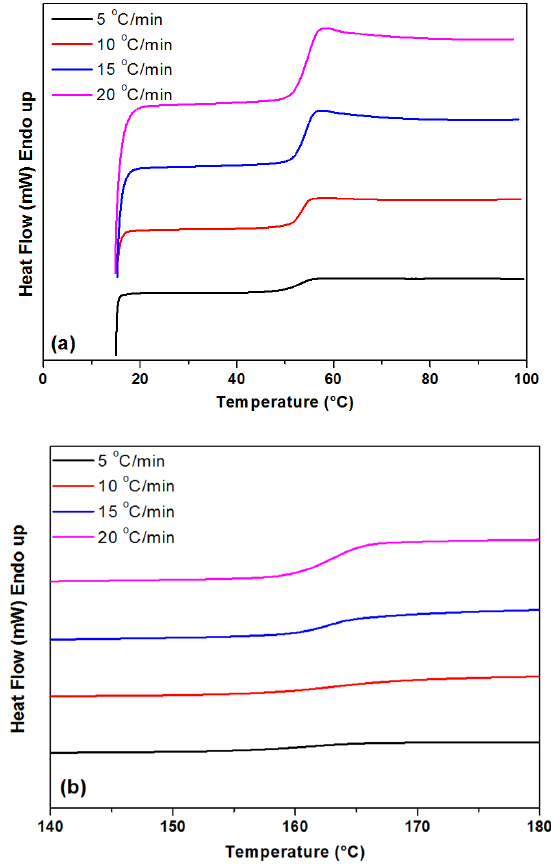
Figure 5. DSC scans of: PMEPF ( a ); and PIF ( b ) glass transition temperature at various heating rates.